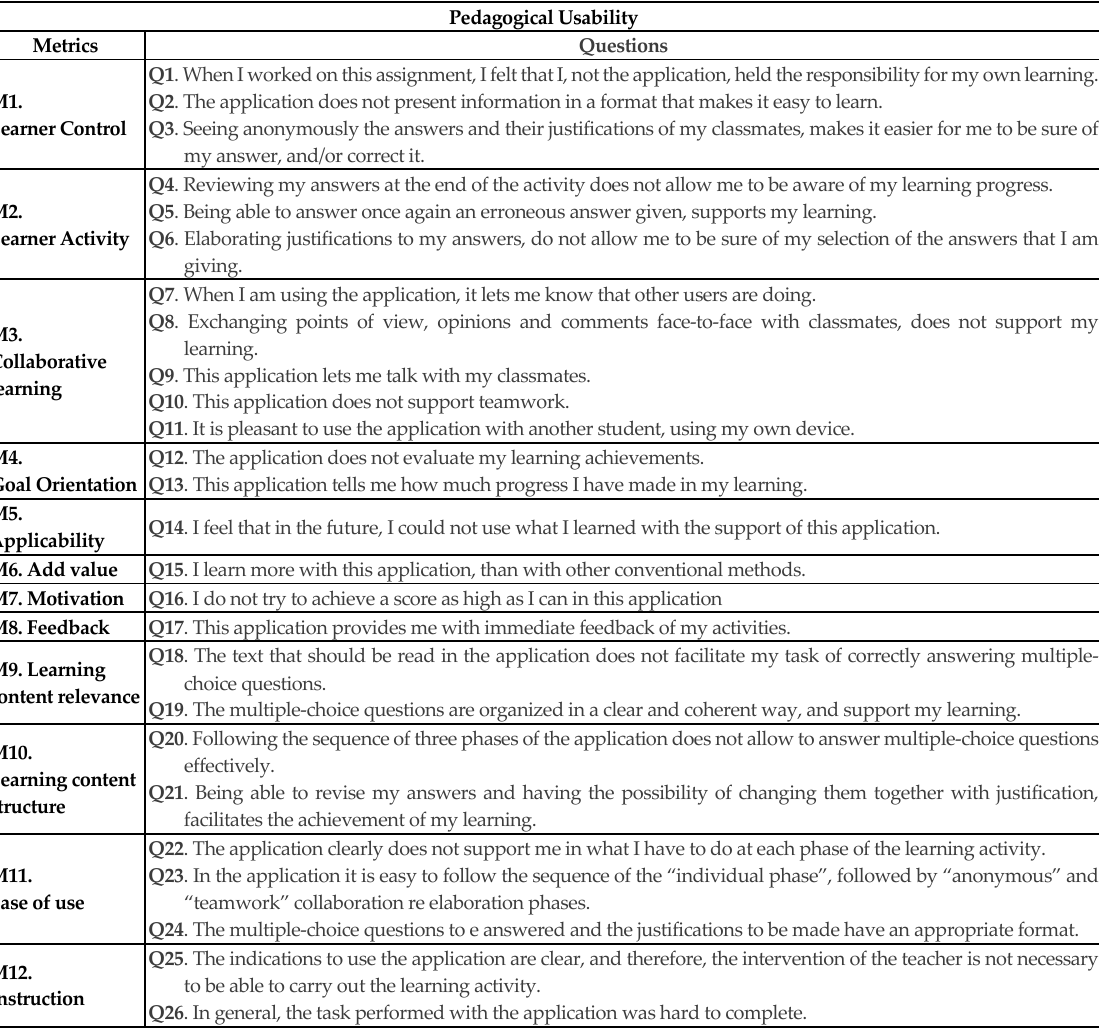
Table 1. Questionnaire to capture students’ perceptions of pedagogical usability of RedCoMulApp